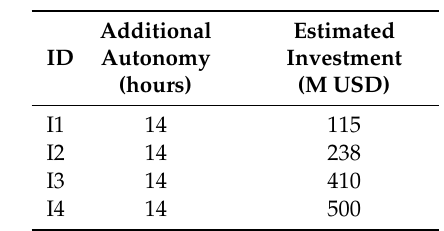
Table 8. Alternative infrastructure evaluated by the water company.